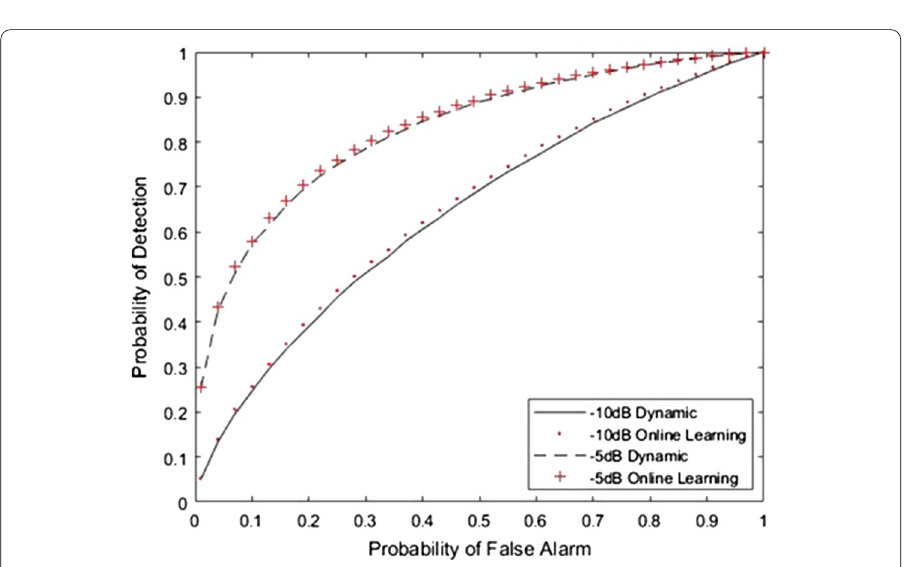
Fig. 8 ROC ( P d vs P fa ) of energy detector sensing under Weibull fading channel ( a